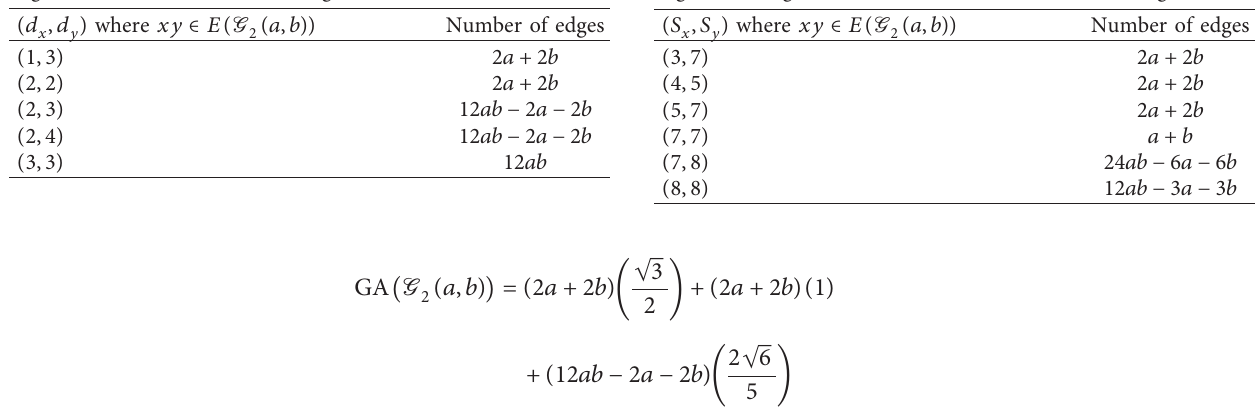
( a, b ) based on sum of 2